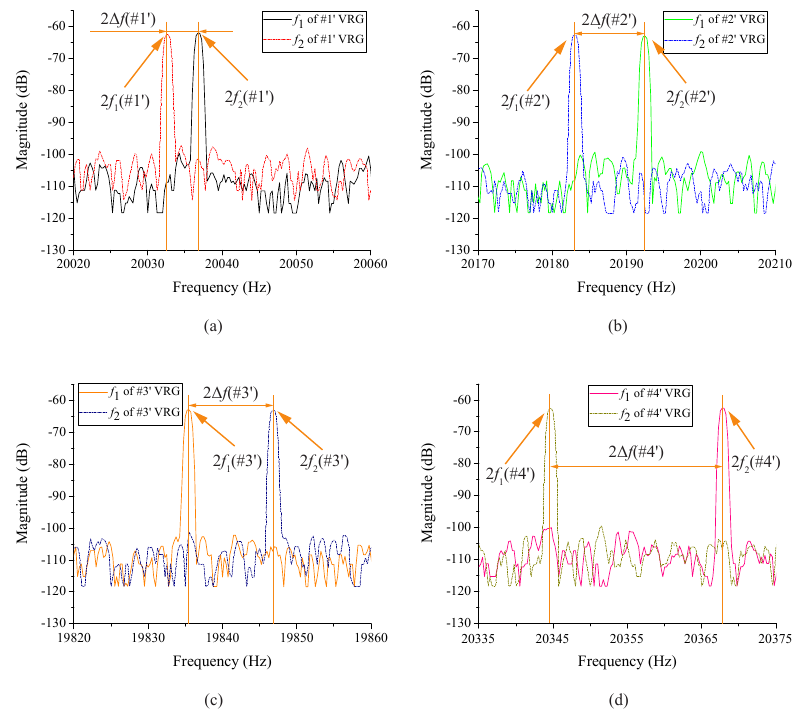
Figure 9. Second harmonic frequency data of four (111) VRG samples: ( a ) #1’ VRG, ( b ) #2’ VRG, ( c ) #3’ VRG, ( d ) #4’ VRG.